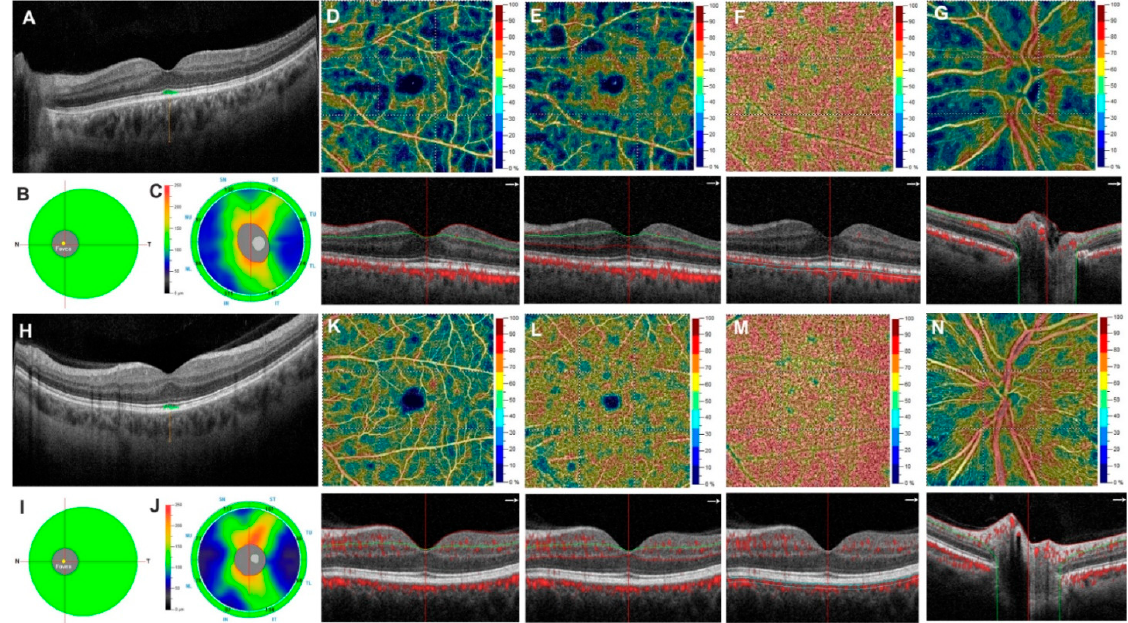
Figure 1. Top row. Left eye of a 65-year-old patient undergoing chronic long-term therapy with tadalafil shows an increased subfoveal choroidal thickness (SFCT) ( A ) and a normal ganglion cell complex (GCC) and retinal nerve fiber layer (RNFL) parameters ( B , C ). In OCTA images, the retinal superficial, deep capillary plexuses ( D , E ) and the radial peripapillary capillary plexus ( G ) reveal areas of reduced vessel density and no change in choriocapillaris vessel density ( F ). Bottom Row. Left eye of a 63-year-old healthy subject (part of the control group) presents normal SFCT ( H ) and normal GCC and RNFL parameters ( I , J ). OCTA images reveal normal vessel density in retinal superficial, deep capillary plexuses, choriocapillaris and radial peripapillary capillary plexus ( K – N ).